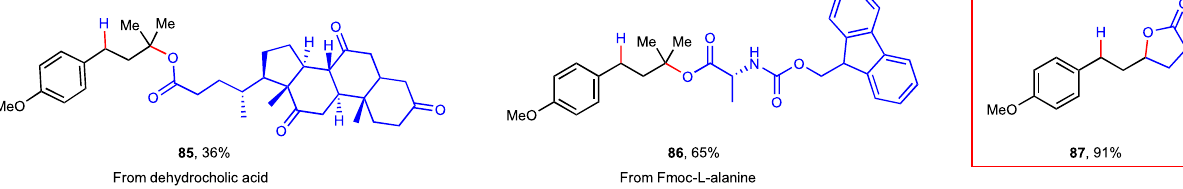
Fig. 4 | Substrate scope of photoredox-coupled C( sp 3 ) – heteroatom bond for- mation with carboxylic acid as nucleophile. Reaction conditions: arylcyclopro- pane (0.2mmol,1 equiv.),carboxylicacid (2equiv.),photocatalyst(2mol%),(PhS) 2